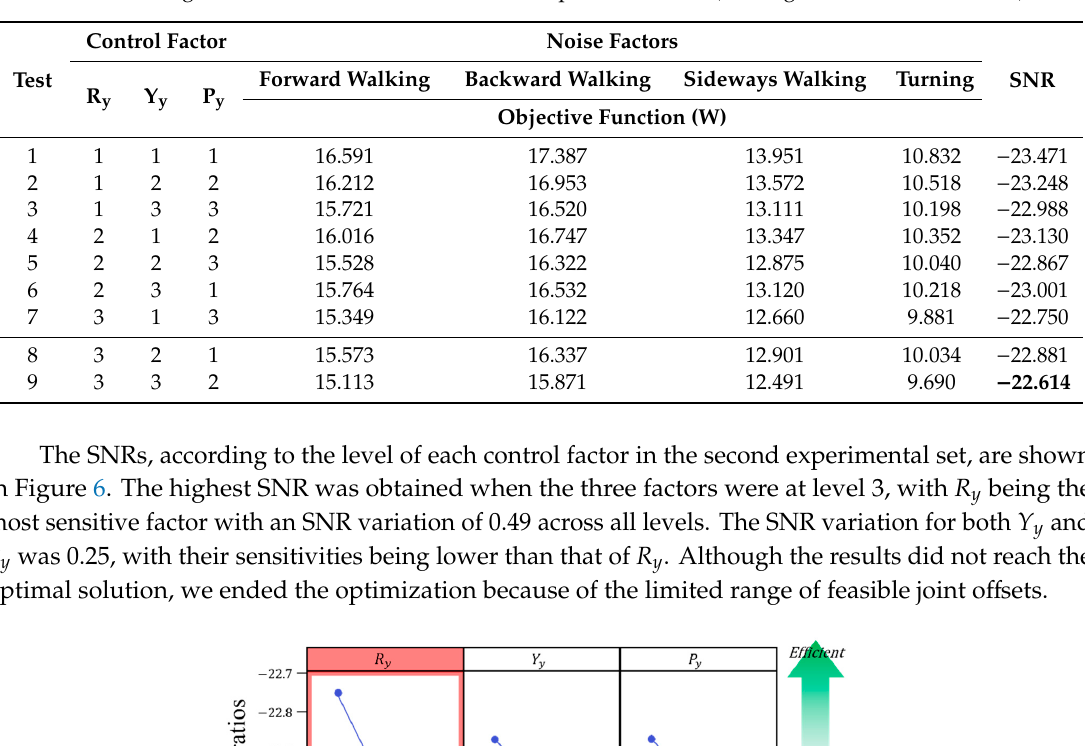
–15 Figure 7. Hip joint configuration of ( a ) the original model and ( b ) the model after the second optimization. 5.1. Forward and Backward Walking Table 6 lists the power consumption in the hip, using the original model and the optimized models after the first and second experiments for forward and backward walking. For forward walking, the RMS power at the hip joint reduced by 18.07% and 26.92% for the models after the first